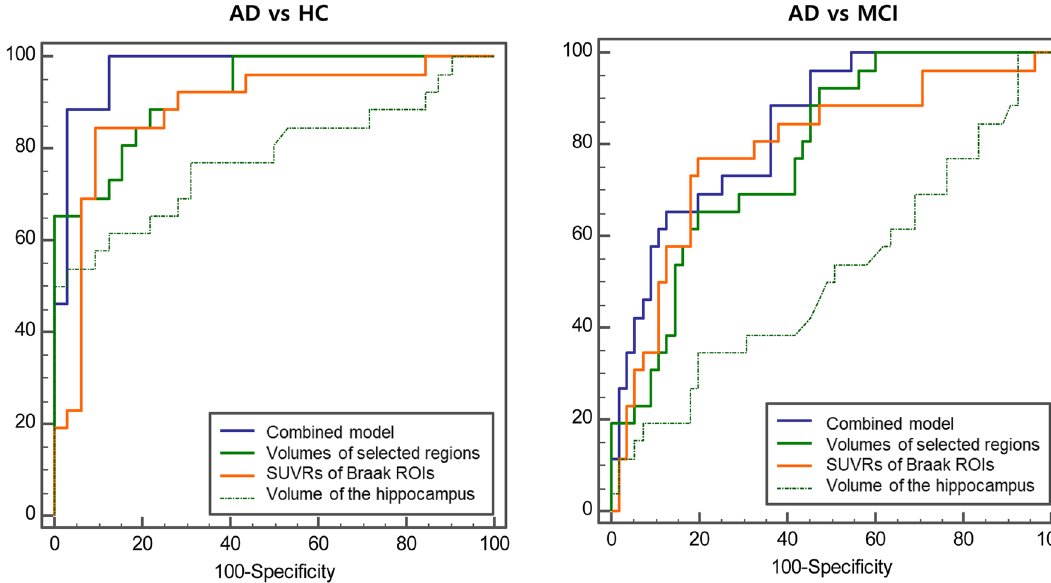
Figure 3. Combined and individual performance of volumes of selected brain regions, SUVRs of Braak ROIs and volume of the hippocampus in discriminating AD from HC and MCI. The performance was calculated using area under the receiver operating characteristics analysis. The performances of the combined model, volumes of selected brain regions (cingulate isthmus, inferior parietal lobule, hippocampus), SUVRs of Braak ROIs (Braak I/II, III/IV, V/VI) and volume of the hippocampus were compared in discriminating AD from HC (left) and MCI (right). AD = Alzheimer’s disease, HC = healthy control, MCI = mild cognitive impairment, ROI = region of